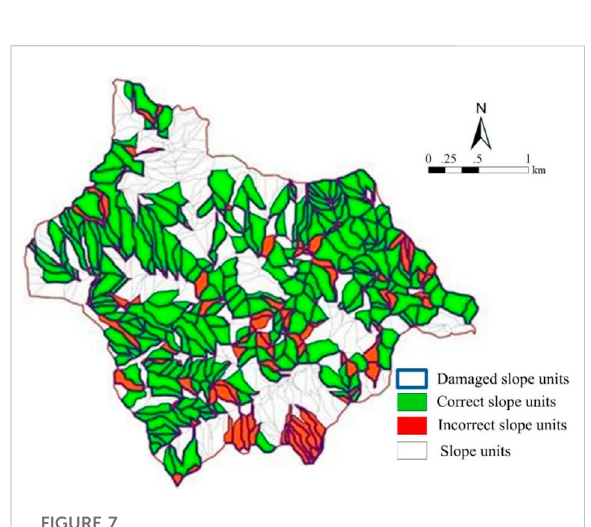
FIGURE 7 Comparison between the calculated results from the landslide early warning model and the actual